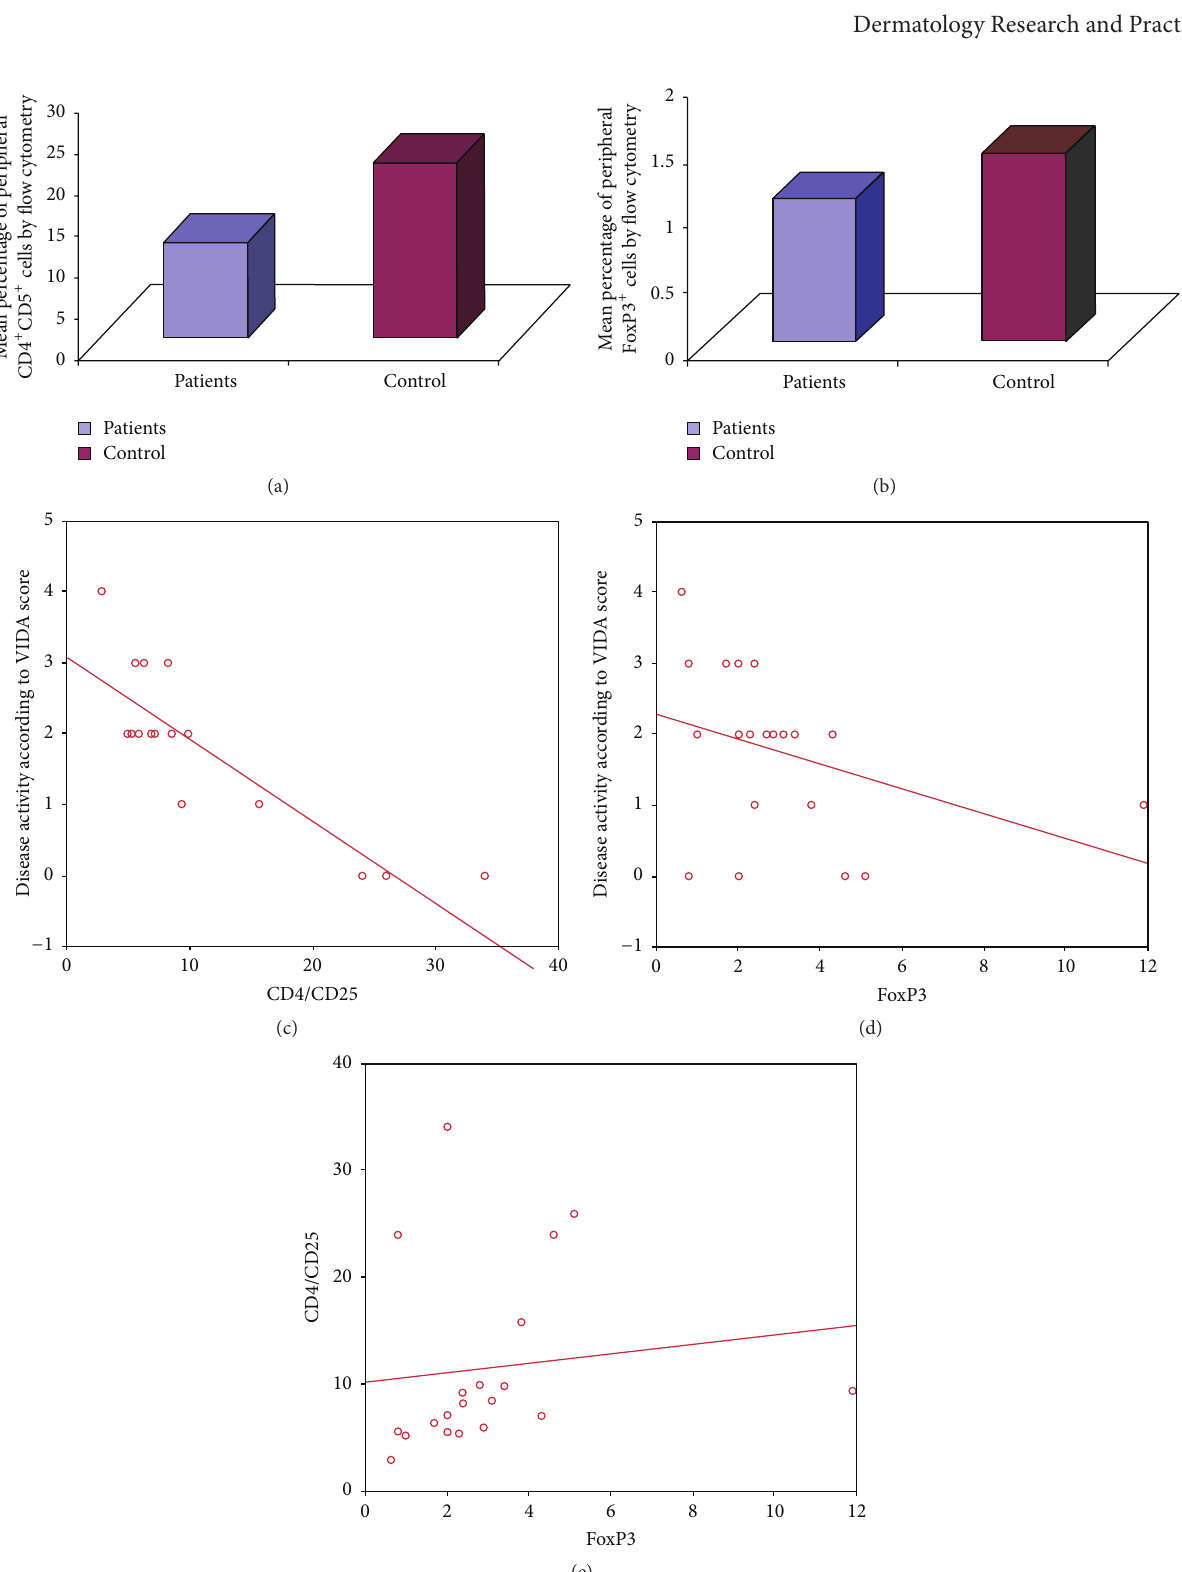
Figure 2: (a) The mean percentage of peripheral CD4 + CD25 + Treg was significantly reduced in vitiligo compared to healthy controls. (b) The mean percentage of peripheral FoxP3 + T cells from total peripheral CD4 + cells was significantly reduced in vitiligo patients compared to controls. (c) Correlation between percentage of peripheral CD4 + CD25 + lymphocytes and VIDA score. (d) Correlation between percentage of peripheral FoxP3 + lymphocytes and VIDA score. (e) Correlation between percentage of peripheral FoxP3 + lymphocytes in vitiligo patients group and the percentage of CD4 + CD25 + lymphocytes in vitiligo